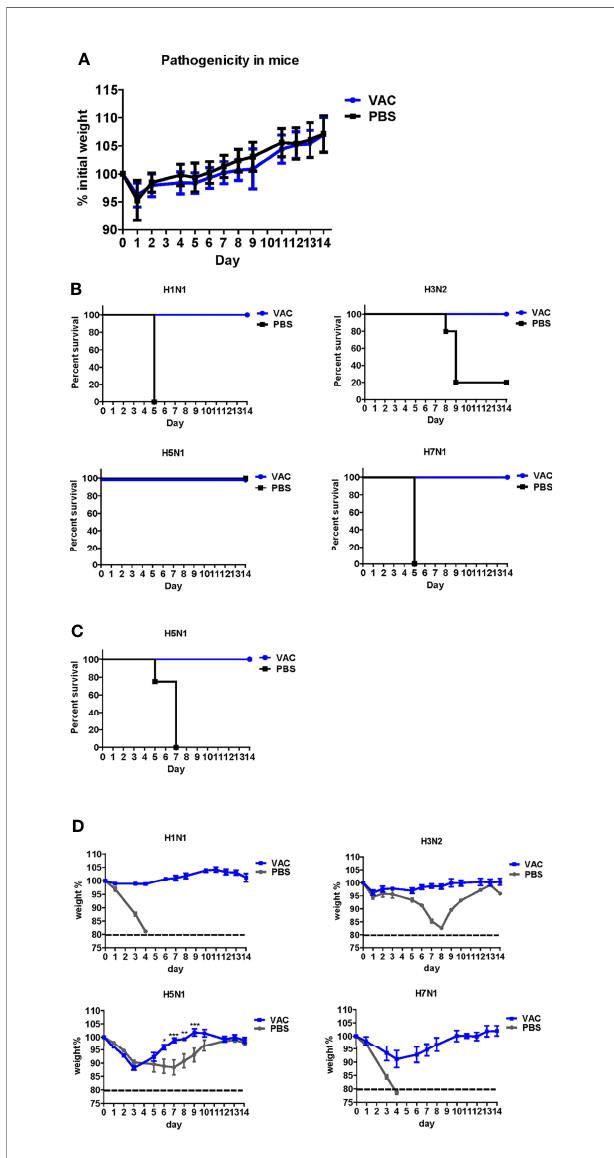
FIGURE 2 | Protective ef fi cacy of DM-C against four types of in fl uenza A viruses. (A) Pathogenicity con fi rmation of DM-C in animal models. After acclimating six-week-old mice for 1 week, the mice were vaccinated with 10 5 PFU/50 m L of DM-C LAIV (group VAC) or 50 m L of PBS (PBS group). The mice were observed daily for 2 weeks to check changes in the body weight and survival rate. No clinical symptoms were observed in both groups. The graph shows the mean of each cohort ( N=20 ), and the error bar means the standard deviation (SD). (B, C) Mice were challenged with two subtypes of group 1 and 2 in fl uenza A viruses each. Mice were challenged with H1N1, H3N2, and H7N1 at 2 mLD50 and with H5N1 (6×10 5 PFU) at a survivable dose. Mice were monitored daily. The survival rates (B) and changes in bodyweight (D) are shown. The humane endpoint is a weight-loss reduction of more than 20%, which is indicated by a dotted line in the graph. The graph shows the mean of each cohort (N=5) , and the error bar means the SD. Two- way ANOVA with RM was performed for comparing the differences between body weight of VAC group and PBS group (***P < 0.001; **P < 0.01; *P < 0.05). (C) Mice were challenged with a lethal dose of H5N1 (2×10 6 PFU) and were monitored daily for body weight and mortality. The survival rates are shown